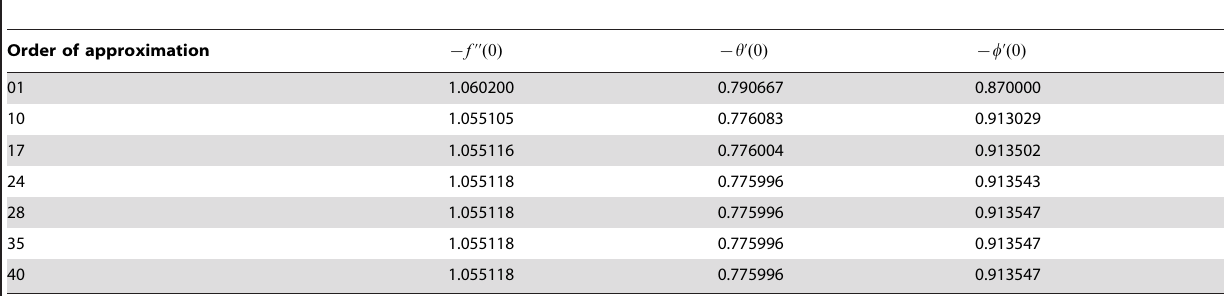
Table 1. Convergence of homotopy solution for different order of approximations when M ~ 0 : 6, b ~ 0 : 4 ~ Rd , l 1 ~ 0 : 5,